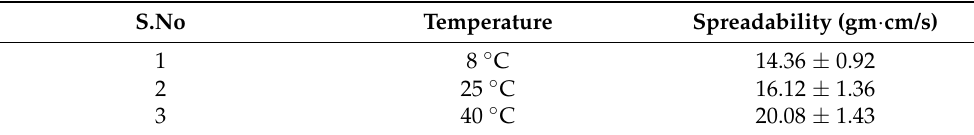
Table 4. Spreading co-efficient of optimized emulgel formulation at different temperatures.